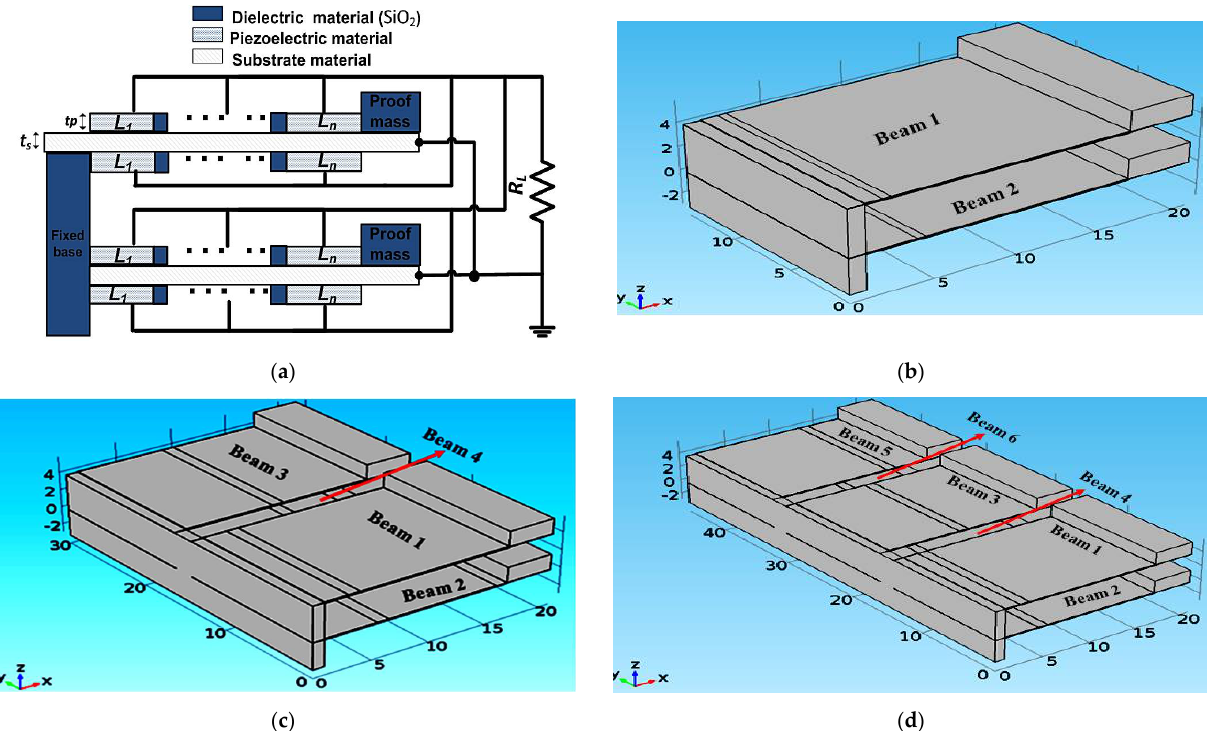
Figure 6. Constructed arrays of the proposed single-beam piezoelectric cantilever structure: ( a ) Demonstration for the two-beam array of the proposed structure at n piezoelectric material segments; ( b ) 3D structure of two cantilever beams array; ( c ) 3D structure of four cantilever beam array; and ( d ) 3D structure of the six beams array.